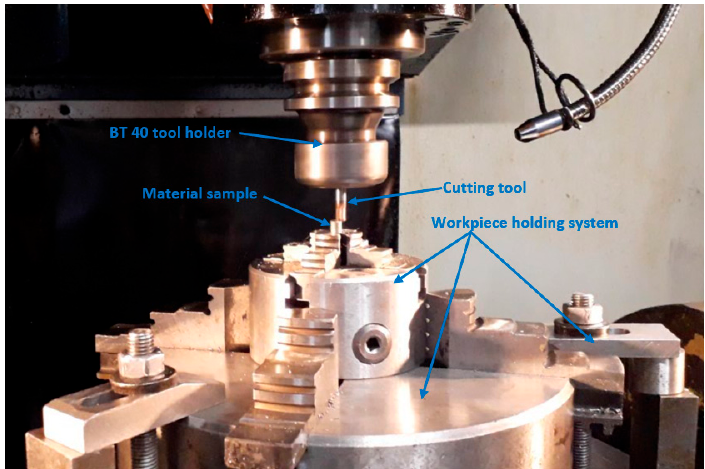
Figure 4. Milling technological system used for the cutting tests. Table 3. Cutting process parameters (variables) and their considered levels. Cutting Parameter Symbols Axial depth of cut (mm)